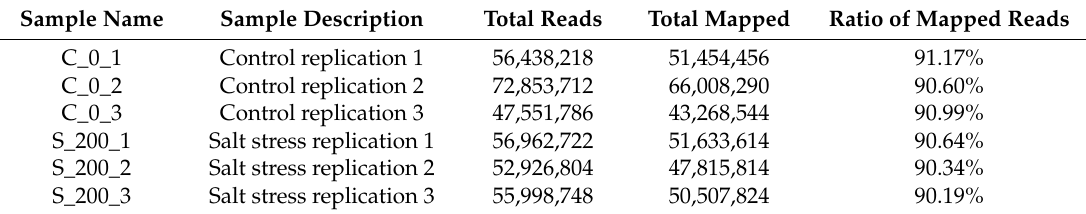
Table 1. Summary of mapping transcriptome reads to reference